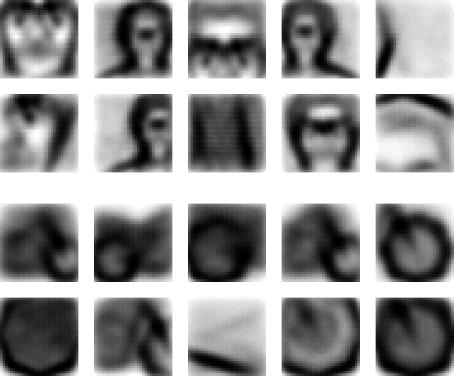
Hebbian Learning(Top) Final reconstructions for the ten face features.(Bottom) The ten motorbike features.